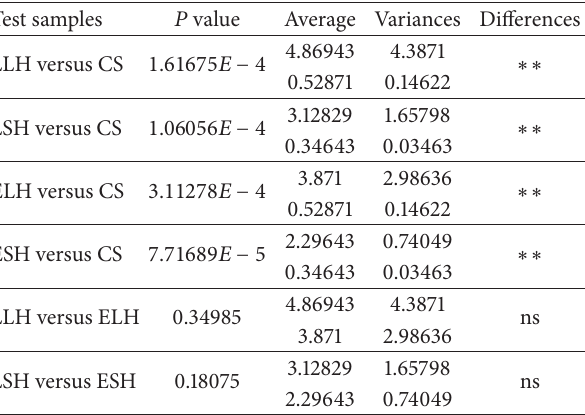
Table 3: The one-way ANOVA for the late, the early, and the control harvests of vegetables.